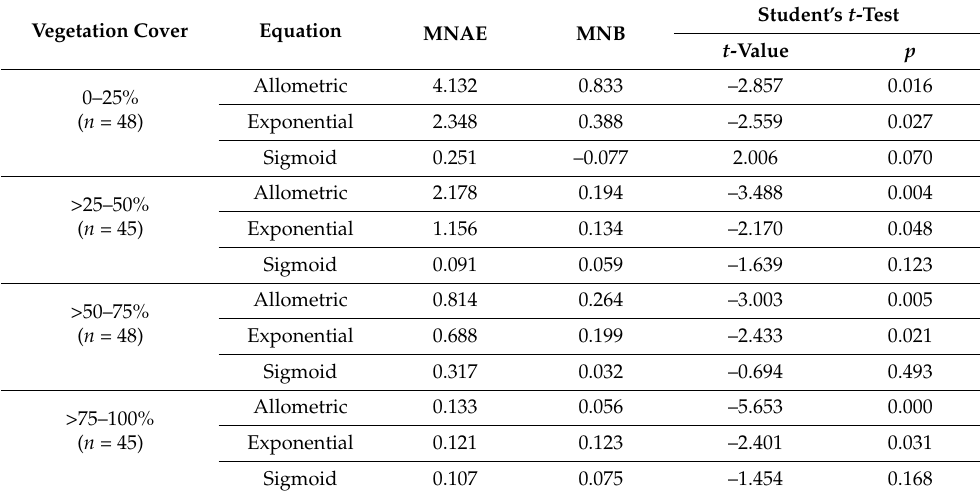
Table 5. Validation indices of volumetric soil organic carbon (SOC) density (kg C/m 3 ) using three functions in ten sites of sabkhas with different vegetation covers along the southern Red Sea coast of Saudi Arabia.